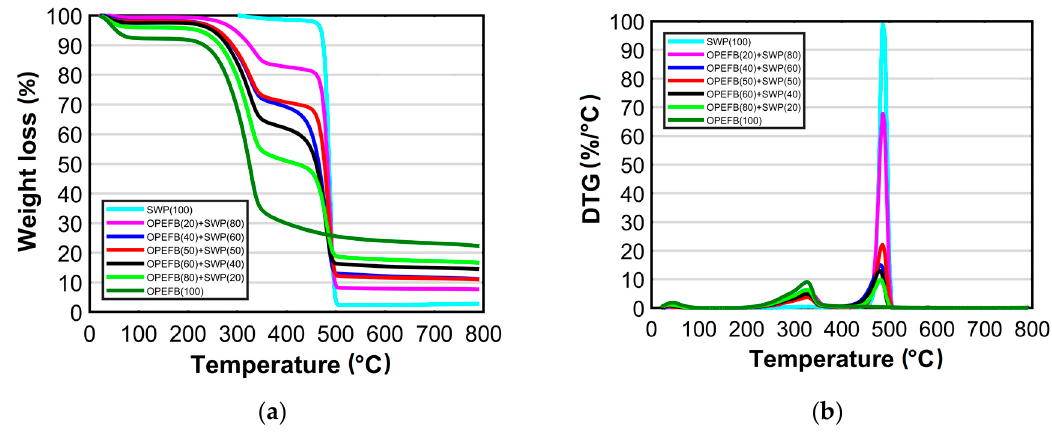
Figure 1. ( A ) TG, and ( B ) DTG curves for OPEFB and SWP samples and their blends at heating rate Figure 1. ( a ) TG, and ( b ) DTG curves for OPEFB and SWP samples and their blends at heating rate of of 10 °C min -1 . 10 ◦ C min − 1